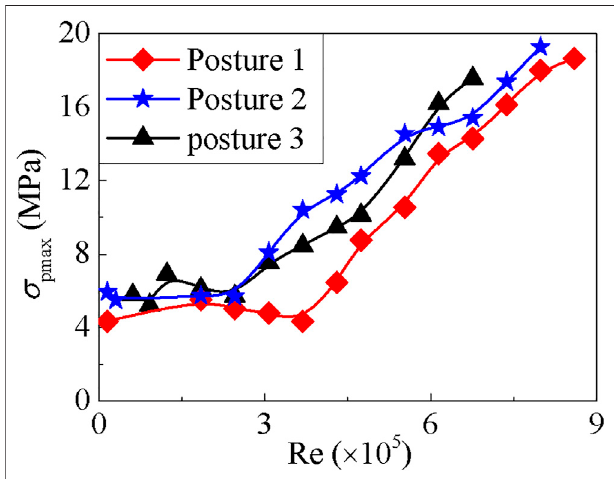
FIGURE 3 | The relationship between the maximum pedal ’ s stress and the Reynold number Re.